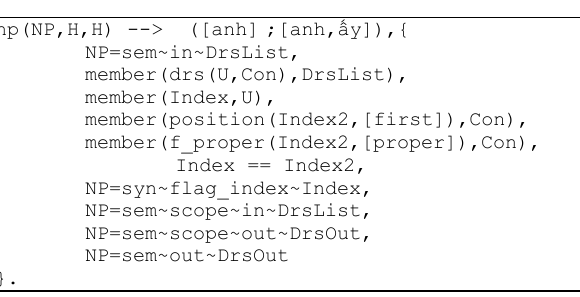
Figure 14. Implement Algorithm 1 based on framework